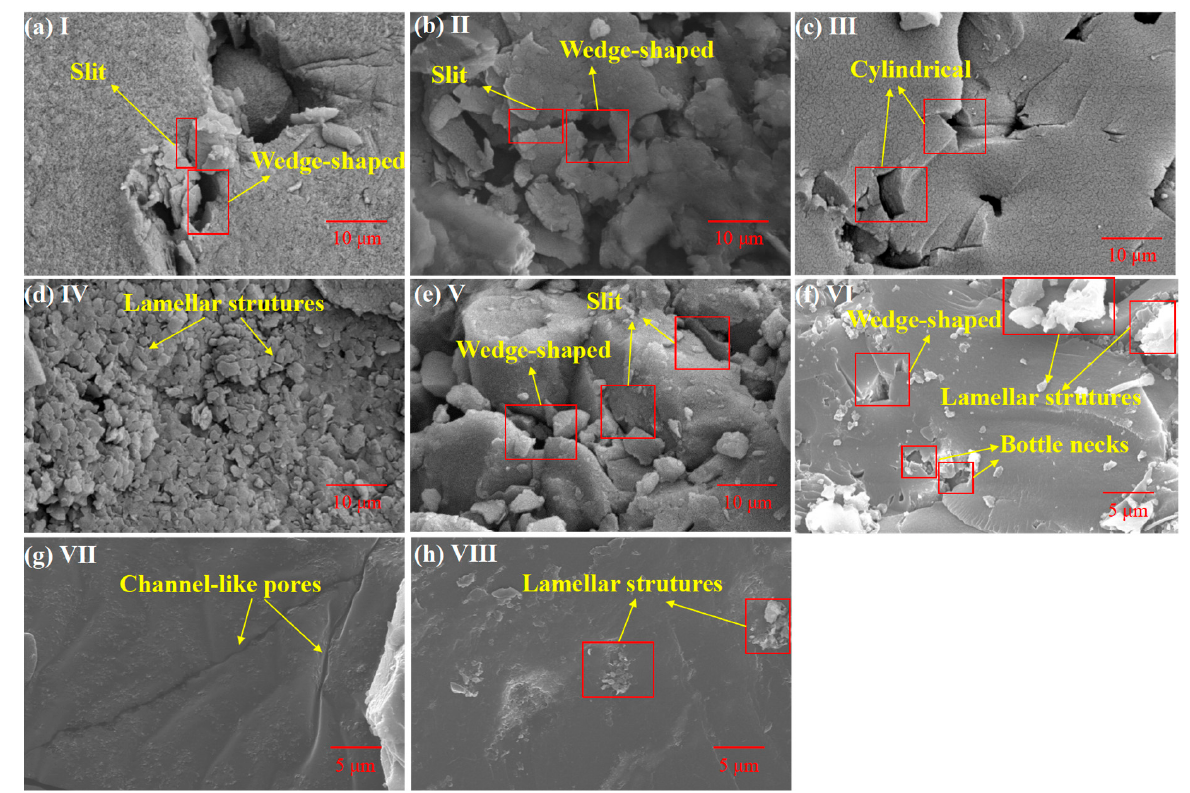
Figure 2. SEM images of different coal samples: ( a ) Sample I; ( b ) Sample II; ( c ) Sample III; ( d ) Sample